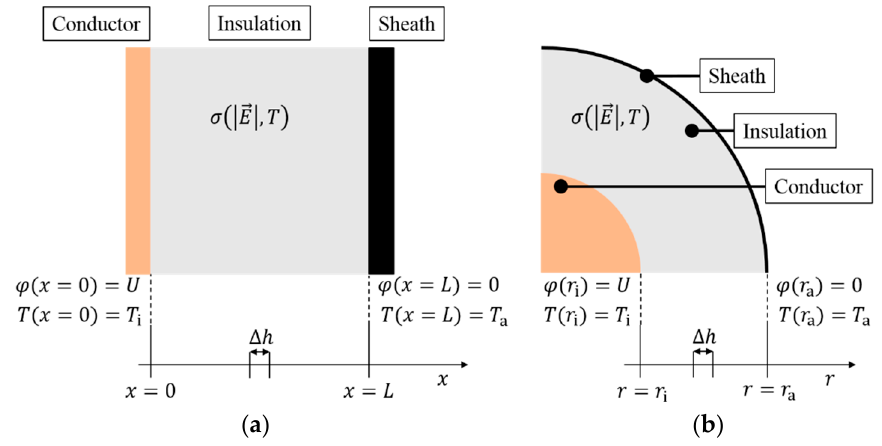
Figure 1. ( a ) geometry of a planplanar insulation; ( b ) geometry of a cylindrical insulation [10].